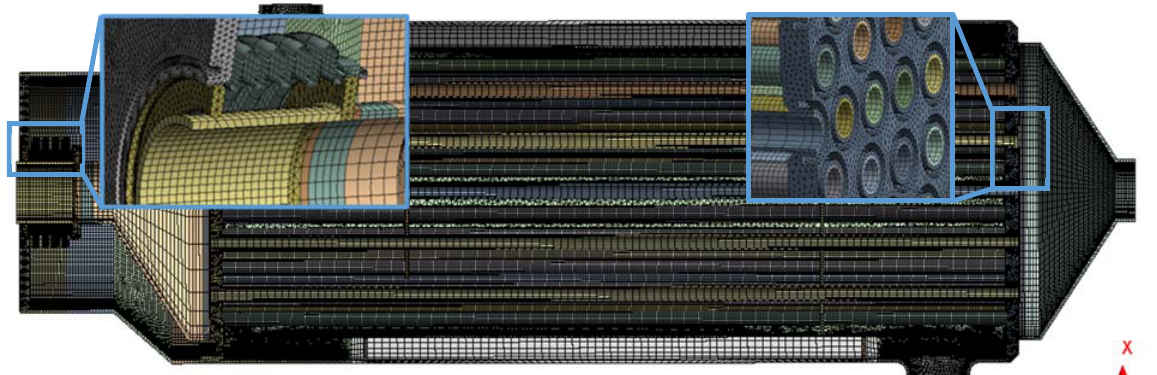
Figure 2: Variant of finite element model of the